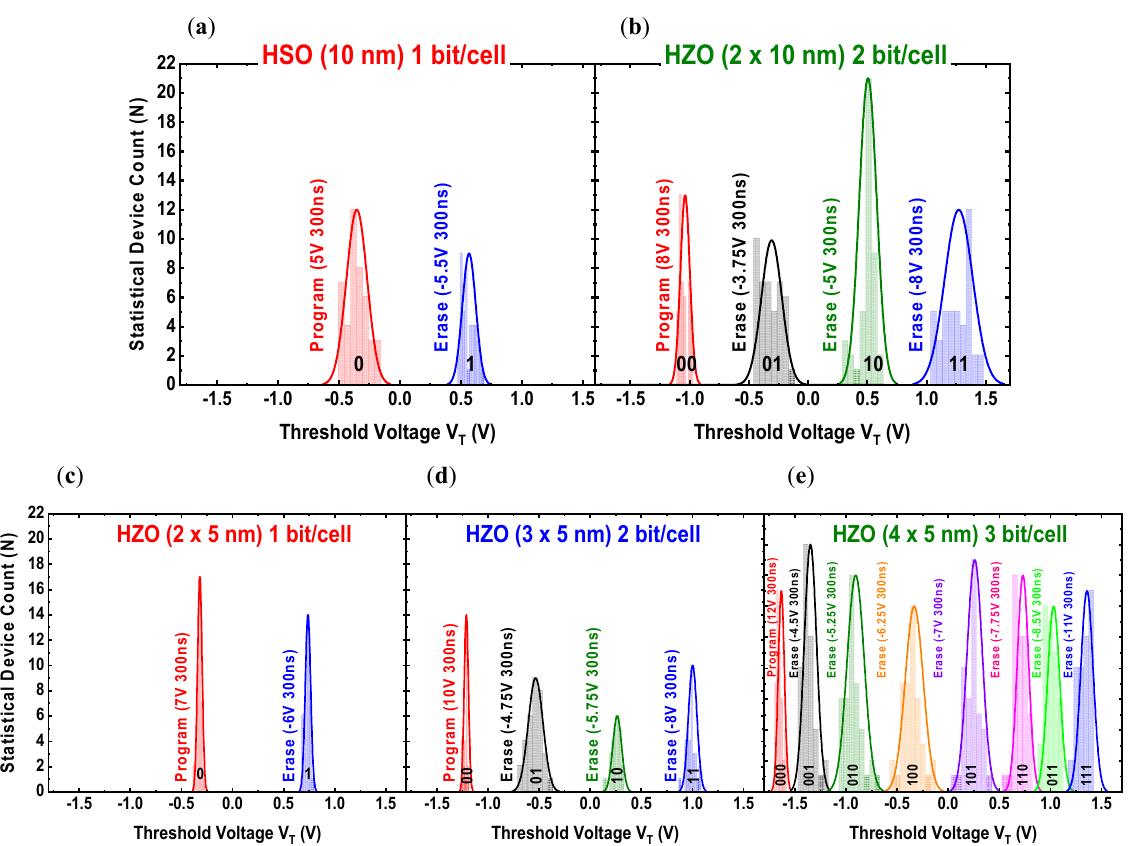
Figure 9. (a – e ) The corresponding histogram V T distribution at selected ER amplitude switching conditions shows the different bit/cell operation capability of the FeFETs indicating an improved MLC density for increased laminate-based ferroelectric thicknesses. Reproduced with permission from [17] T. Ali et al., IEDM; published by IEEE, Copyright 2019, IEEE.